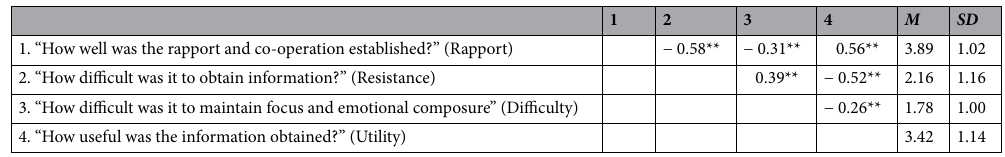
Table 1. Descriptive statistics and inter-correlations of investigative interview reports. Spearman non- parametric correlations across individual investigative interviews (N = 293). * p < 0.05; ** p < 0.01.